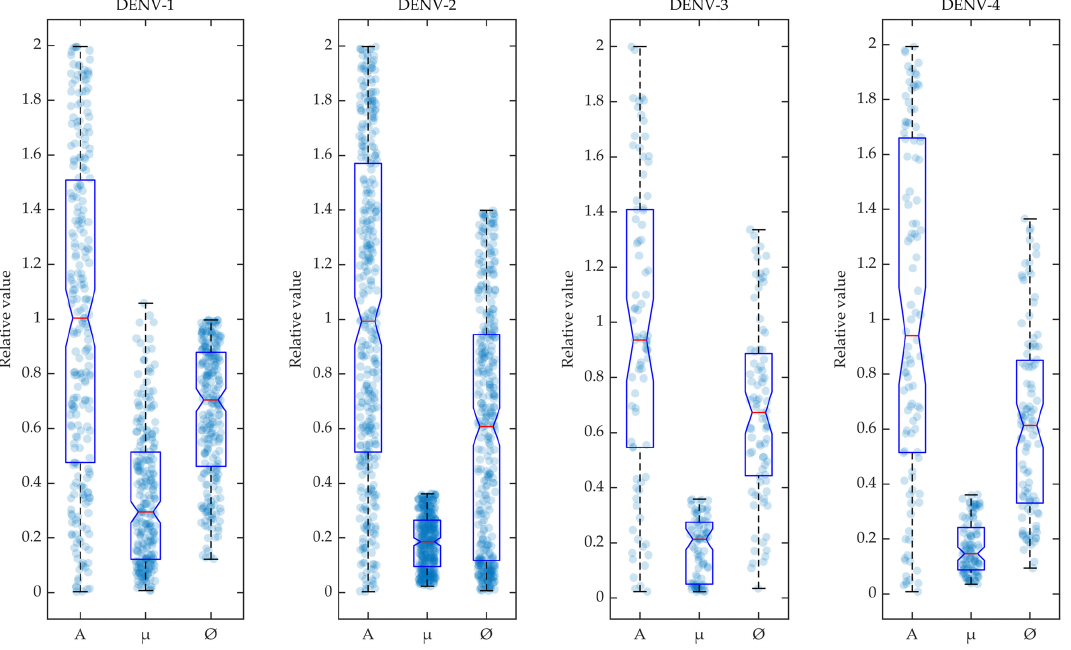
Figure 3. Variability in accepted model parameters: The parameters accepted in the POMs are shown in box plots for the four serotypes. The density of the parameters ( A , µ , φ ) are shown in the scatter plots in the background of the box plots.